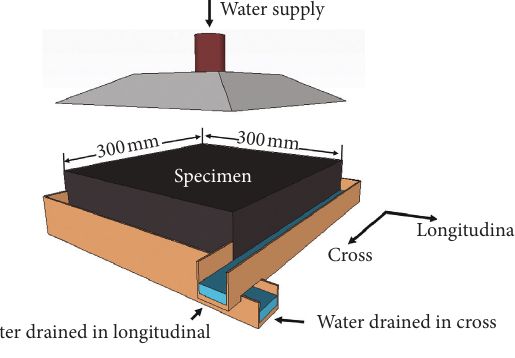
Figure 2: Measurement device.